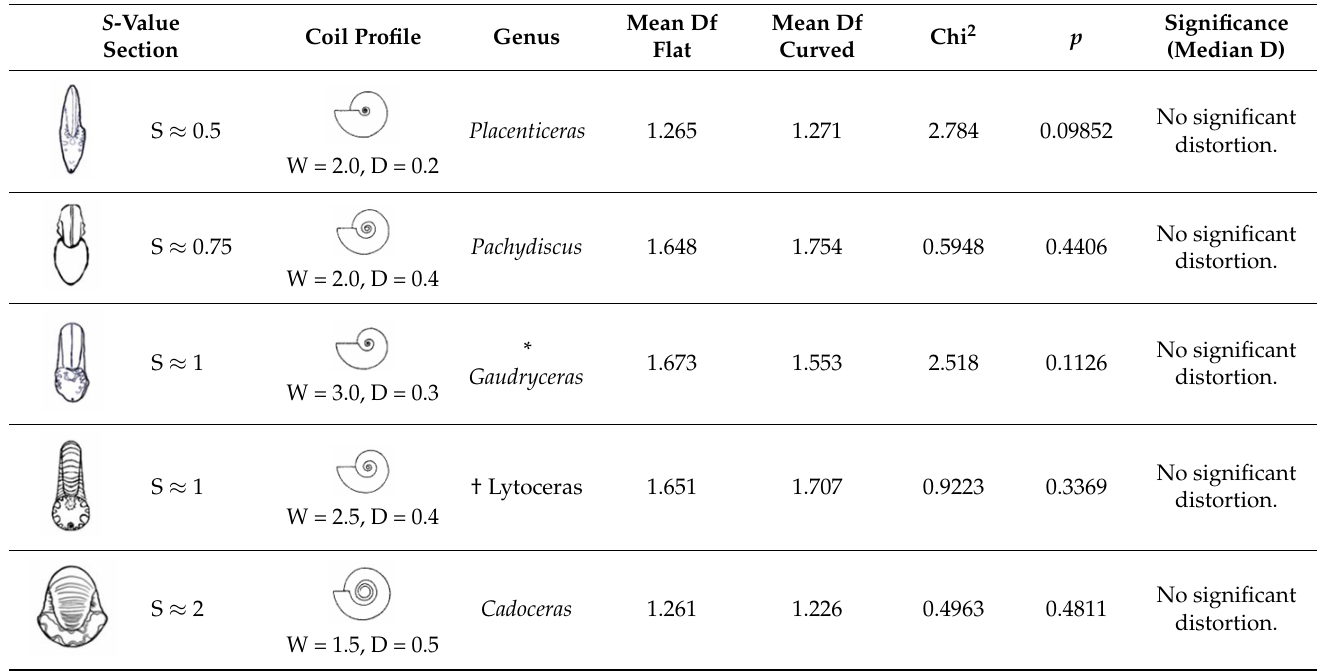
Table 4. Kruskal–Wallis analysis for ammonite conches with W-values from 0.2 to 0.5. Mean Df is the mean fractal dimension value for the given genus, in either the flat or curved data set. Coil profiles redrawn by KM from Raup [46]. Chi 2 shows the difference between the categorical variables flat (traced) and curved (photographed). p is the probability of a difference between the flat and curved medians; for H0 to be accepted, p < Chi 2 . When p < Chi 2 , there is no significant distortion by